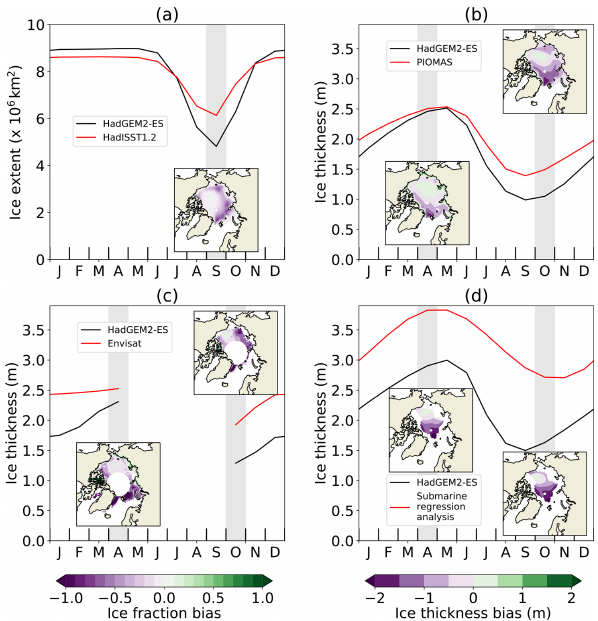
Figure 2. (a) HadGEM2-ES 1980–1999 mean Arctic Ocean ice extent, compared to HadISST1.2 1980–1999, with September ice fraction bias map. (b) – (d) HadGEM2-ES ice thickness compared to (b) PIOMAS 1980–1999, (c) Envisat 1993–1999 and (d) submarine datasets from 1980 to 1999 over respective regions and periods of coverage, with April and October ice thickness bias maps. For each seasonal-cycle plot, the model is in black and reference datasets in red. In (c) , data are not plotted from May to September due to the region of coverage being very